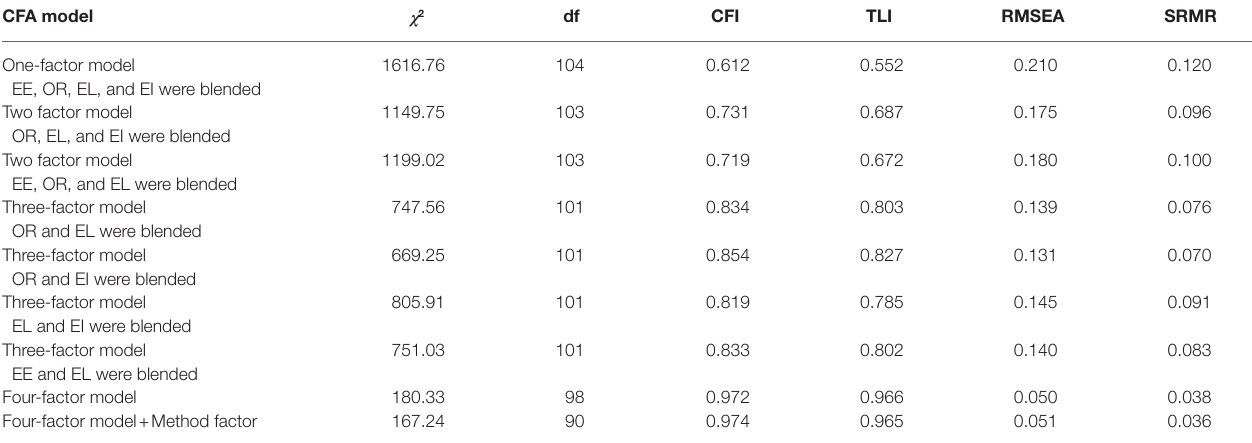
TABLE 2 | Results of confirmatory factor